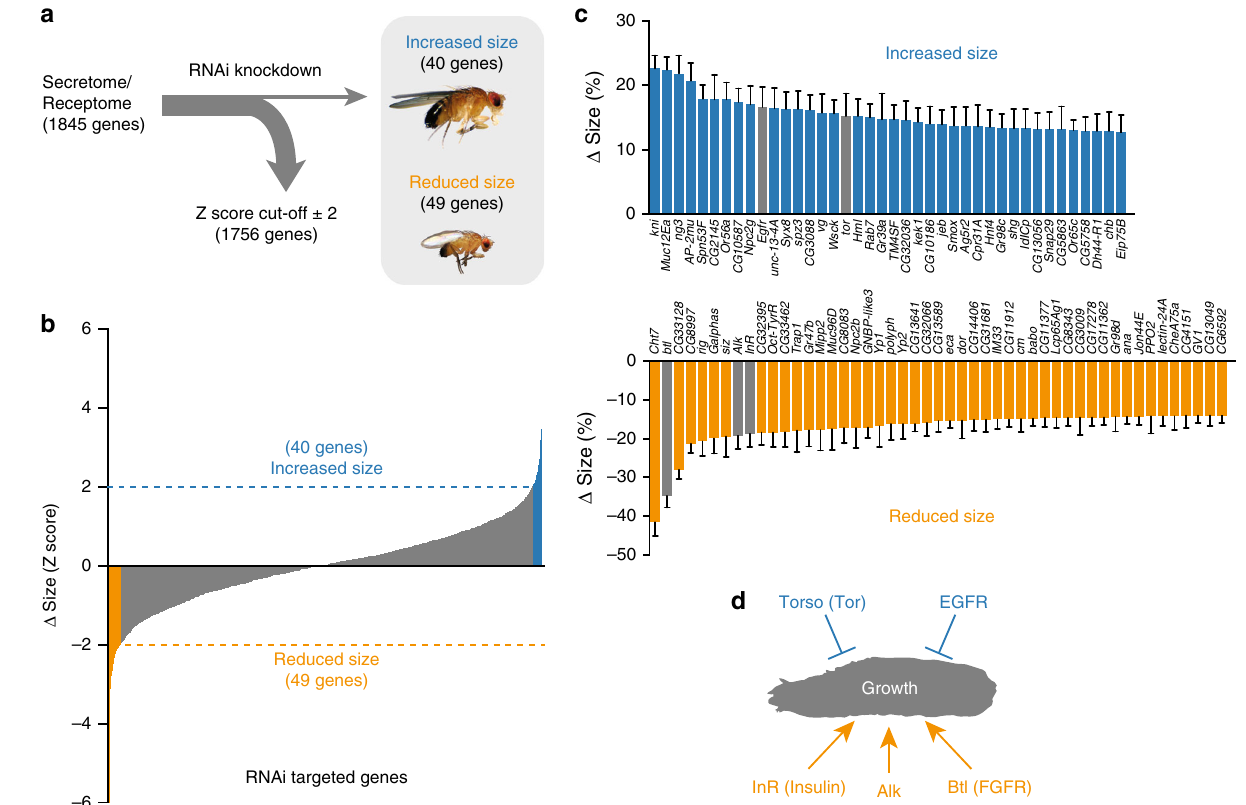
Fig. 1 In-vivo RNAi screen for factors regulating body size. a RNAi screen of 1845 genes of the Drosophila secretome and receptome selected by gene ontology analysis. Upstream activating sequence (UAS)-inducible RNAi constructs against these genes were expressed ubiquitously using da-GAL4 , and pupal sizes were determined (data are presented in Supplementary Data 1). b , c Distribution of the pupal sizes from the screen ( b ) revealed 89 gene hits that resulted in a signi fi cant increase ( c : blue, top) or decrease ( c : orange, bottom) in body size (a Z -score > ± 2 was used as a cutoff) by comparison with the mean of all lines. n = 9 – 55. d Genes and pathways identi fi ed in the screen having known size-regulatory function, as well as breathless ( btl ), are marked with arrows. Error bars indicate SEM. Underlying data are provided in Supplementary Data